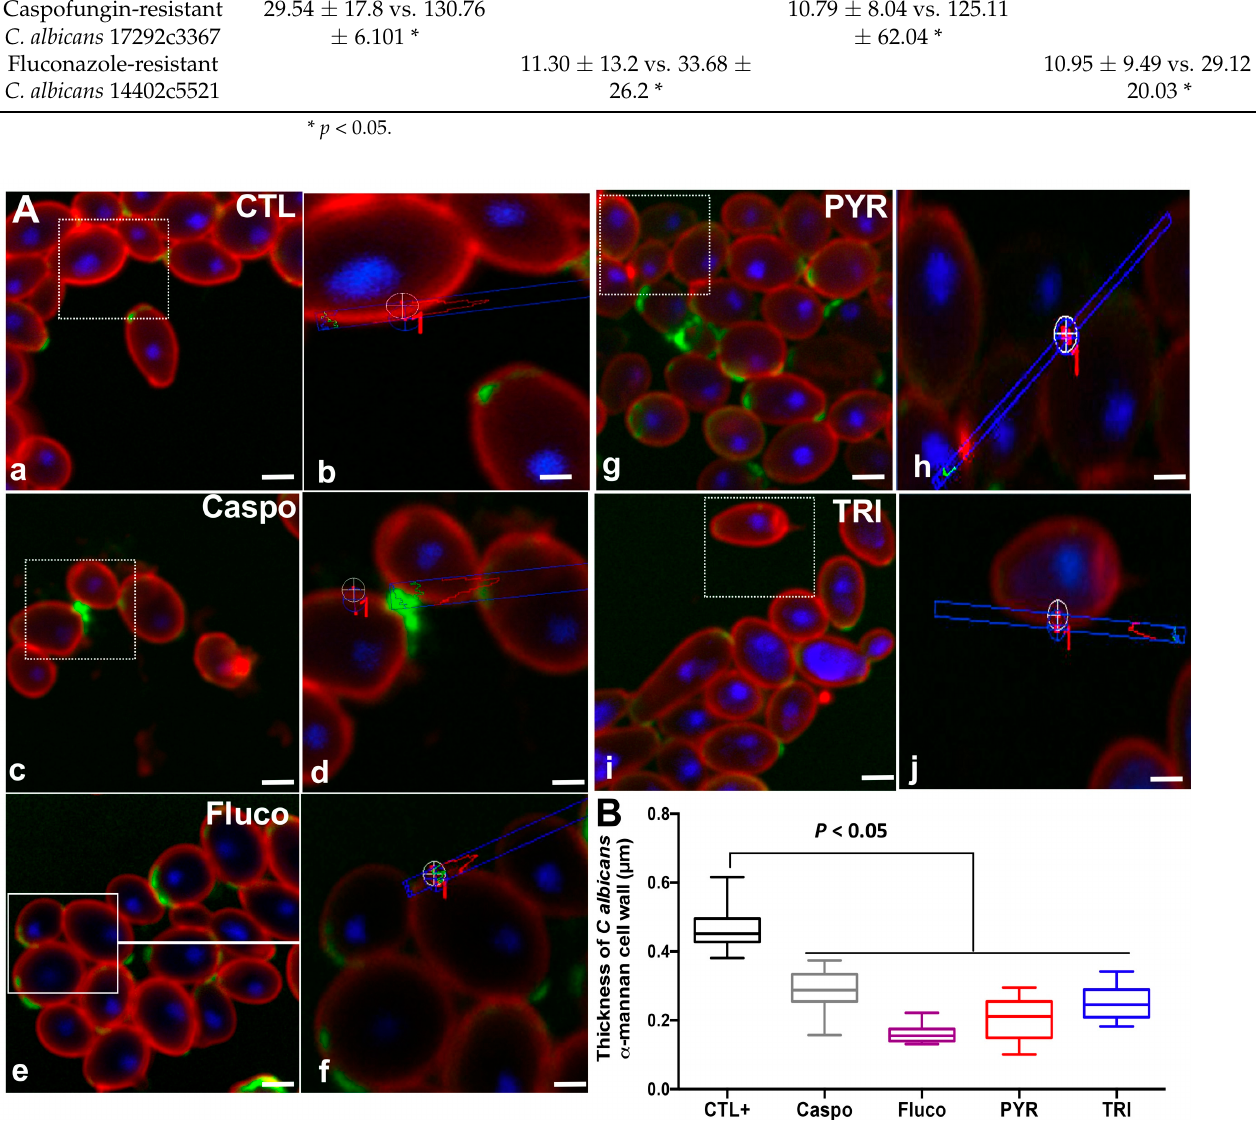
Figure 4. Modulation of chitin and α -mannan in the C. albicans cell wall after antifungal